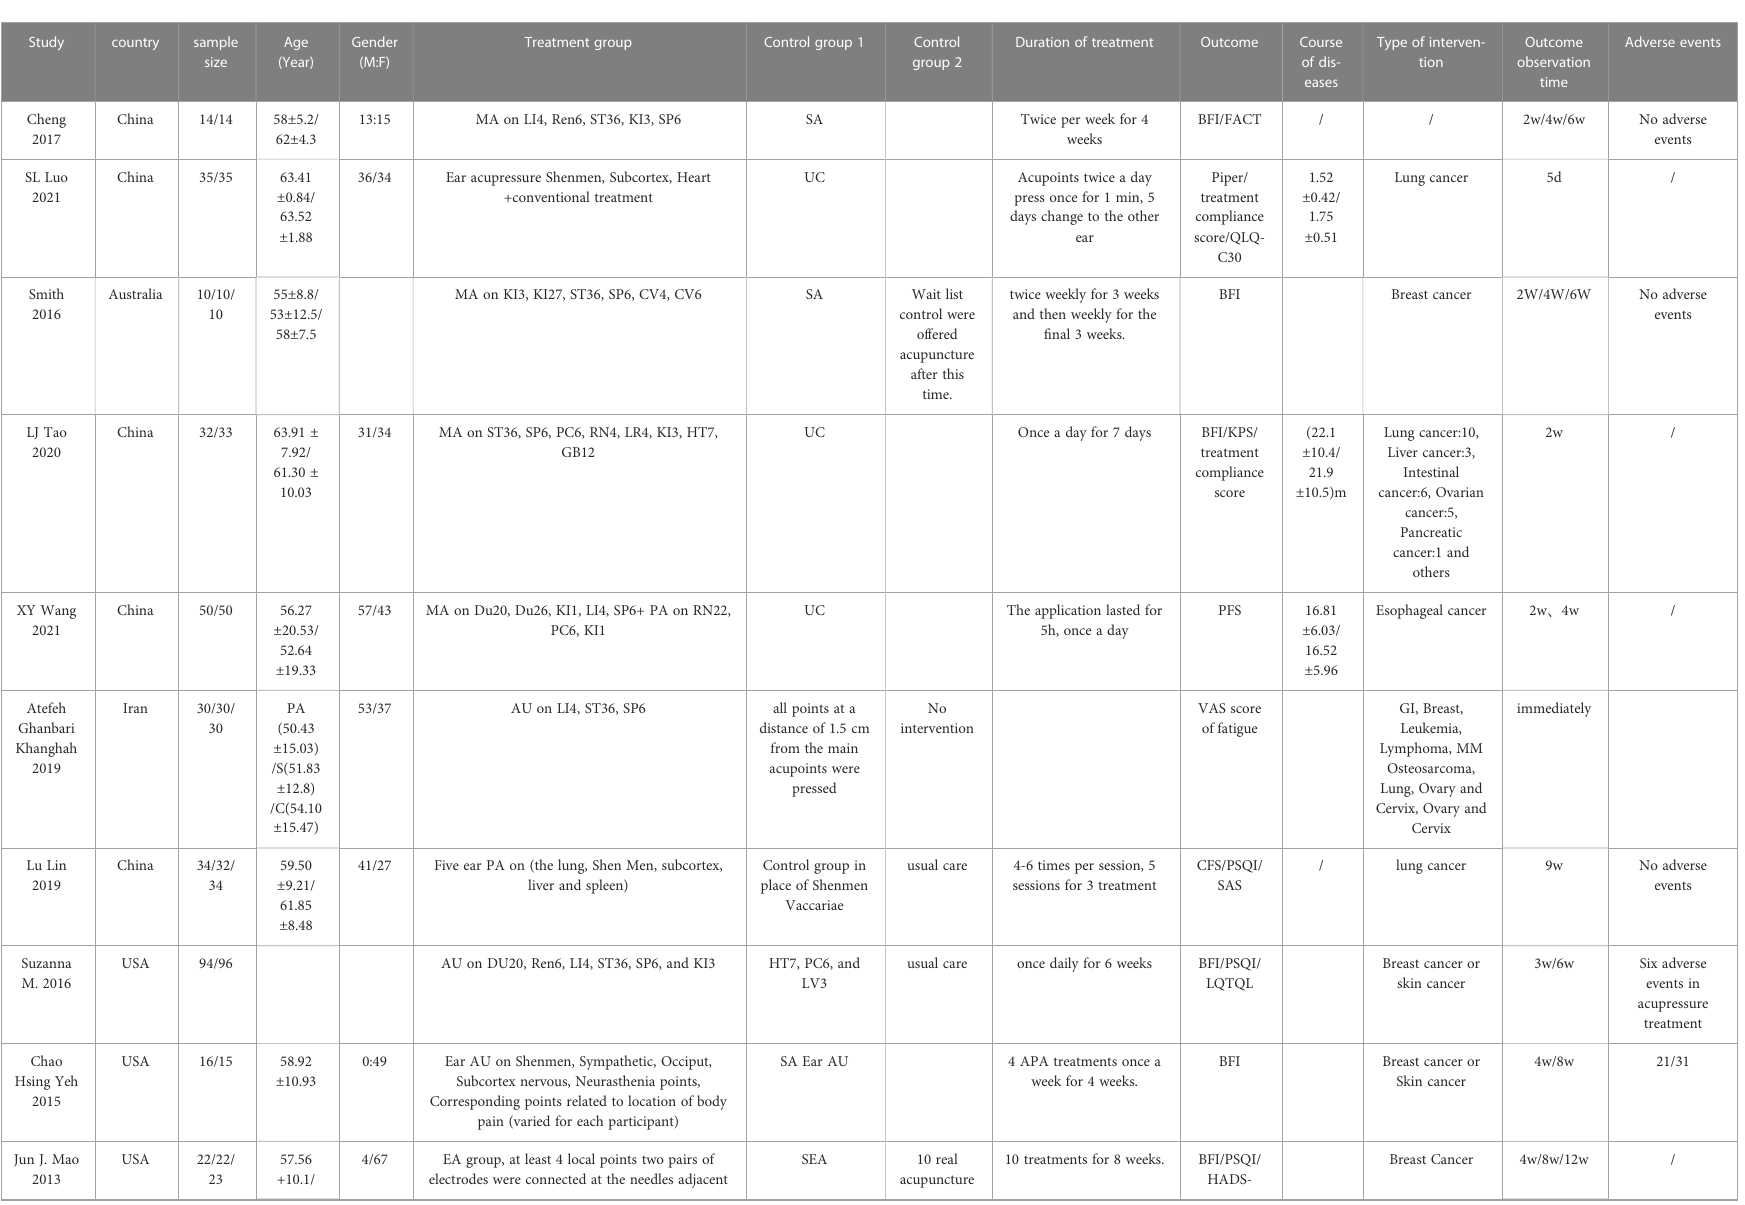
TABLE 1 Characteristics of included